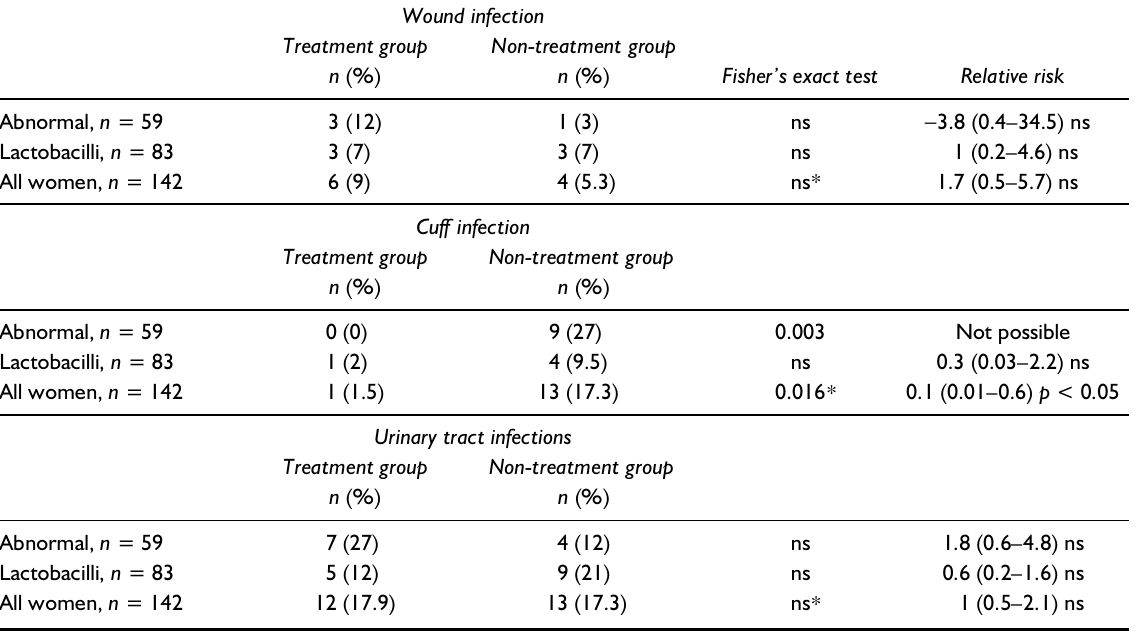
Table 3 Infection rate among women after abdominal hysterectomy and treatment with pre- and postoperative metronidazole 1 g rectally for a minimum of 4